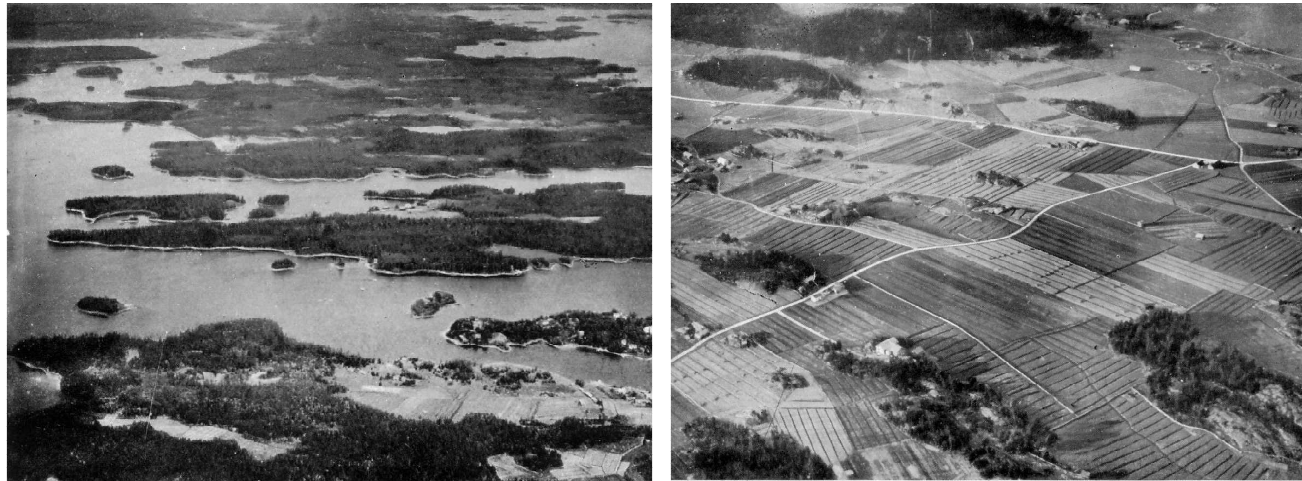
Figure 5: Aerial photographs of „Örtlichkeit“ [„location“] No. 17 (IV 5 AE bc) Borga, Pellinge Skerries (left) and „Örtlichkeit“ No. 3 (V EAF c) Raisio, 6 km NW of Turku (right), (Granö,